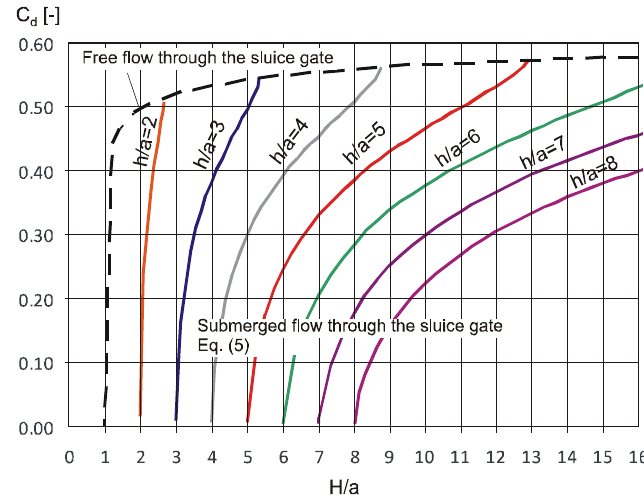
Figure 3. Values of discharge coefficient for different H/a and h/a ratios in the case of a free and submerged flow through the sluice gate [15].